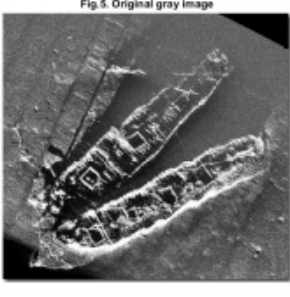
Figure 21. Results for test image Frank Palmer.